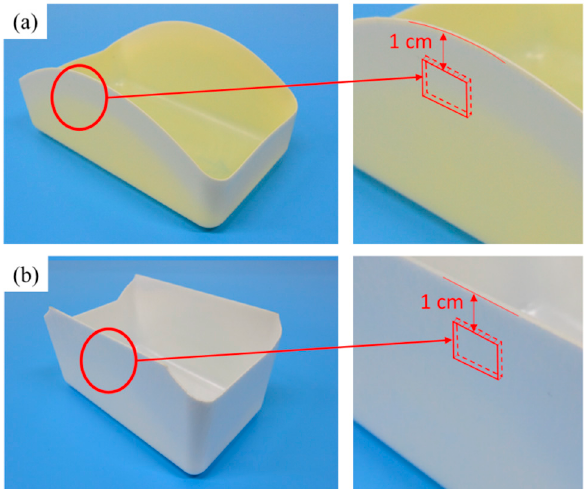
Figure 1. ( a ) Cutout location of the PP specimen for scanning electron microscope (SEM) analysis; ( b ) cutout location of the PS specimen for SEM analysis.